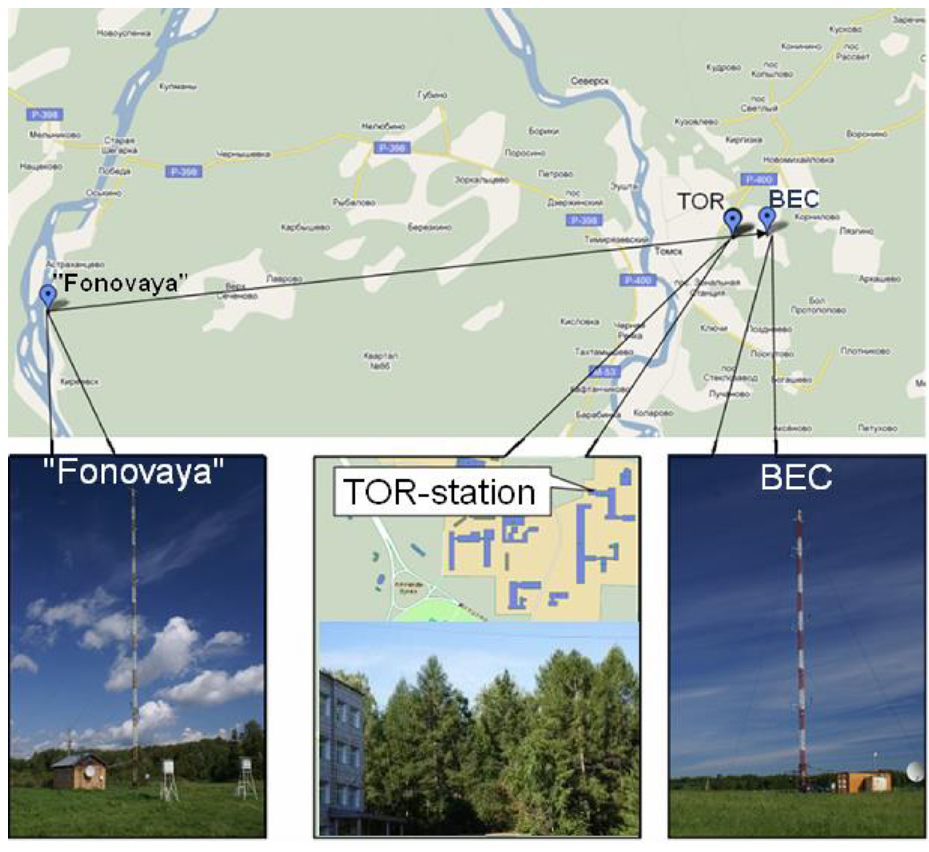
Figure 2. Arrangement of stations for atmospheric